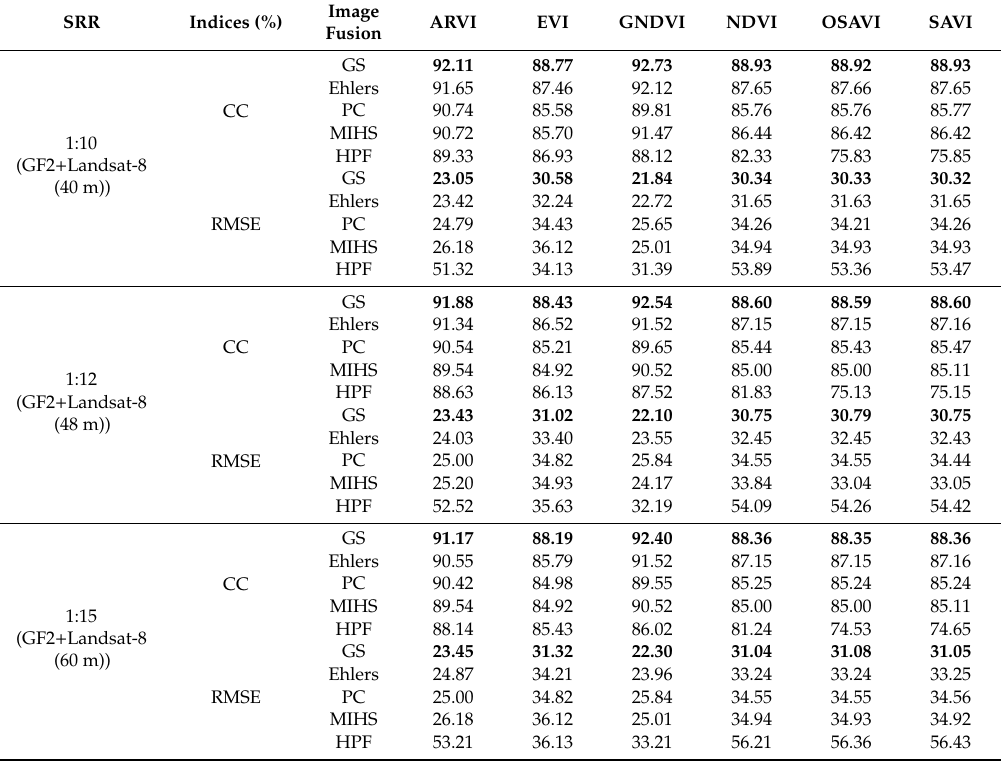
Table 7. Quality of FVI result in multi-sensor fusion (values in bold font indicate good quality). Image SRR Indices (%) ARVI EVI GNDVI Fusion